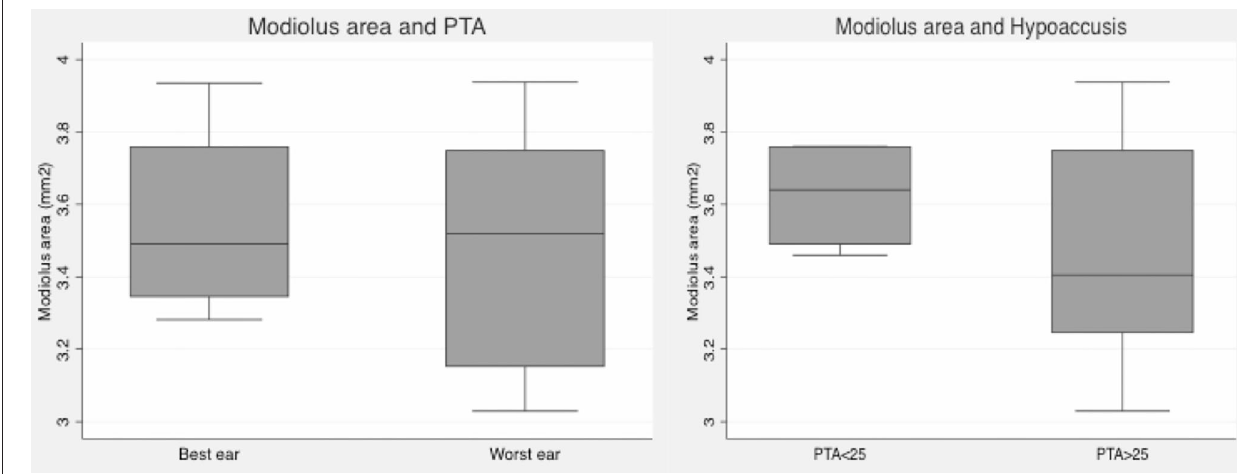
FIGURE 1 | Box plot graphics. Left: Mean modiolar area in best and index ears (based on PTA): no differences were found. Right: Mean modiolar area in ears with normal PTA ( < 25dB) and with hearing loss ( ≥ 25dB): ears with PTA ≥ 25 have smaller modiolus areas, but differences were not statistically significant.